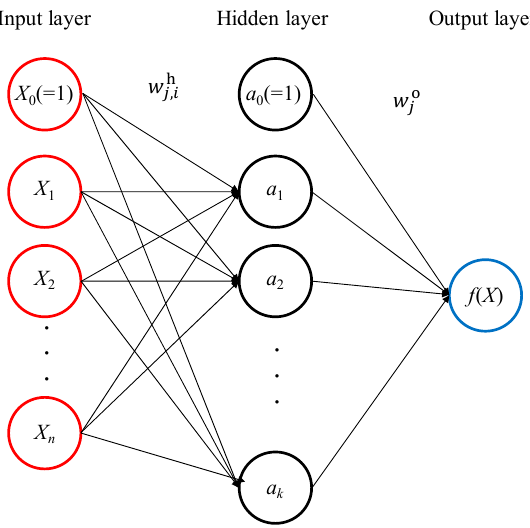
Figure 1. Schematic diagram of multilayer perceptron in an ANN.